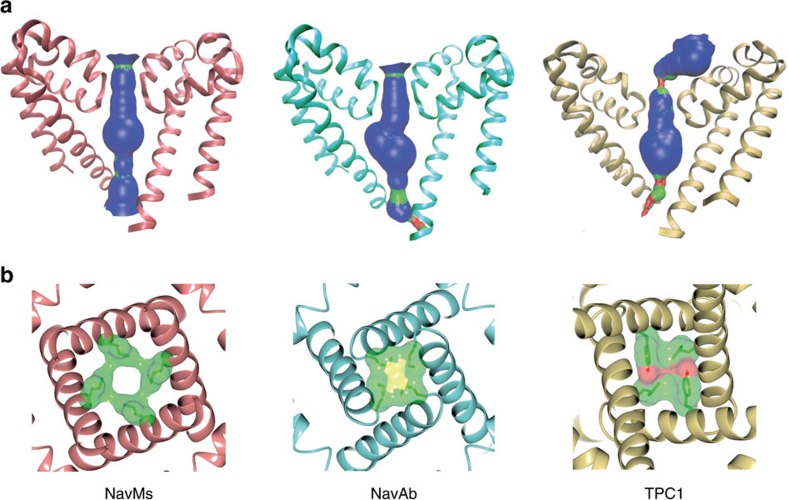
Comparisons of pore sizes and gates.(a) Plots showing the accessible interior of the pore domain and size of the pore gate calculated with HOLE30 for NavMs (open pore), NavAb (closed pore) and TPC1 (closed pore), where blue surfaces (pore radius >2.3 Å) are compatible with sodium ion translocation, green surfaces are radii between 1.2 and 2.3 Å, and red <1.2 Å. (b) Views (from the intracellular side) of the pore gates for NavMs, NavAb and TPC1 channels overlaid with semi-transparent space-filling models of the gate residues (point of narrowest constriction), coloured by the atom type (NavMs: Ile215; NavAb: Met221; TPC1: Tyr305 and Leu672).